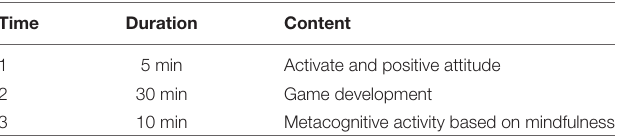
TABLE 1 | Sessions’ game structure.